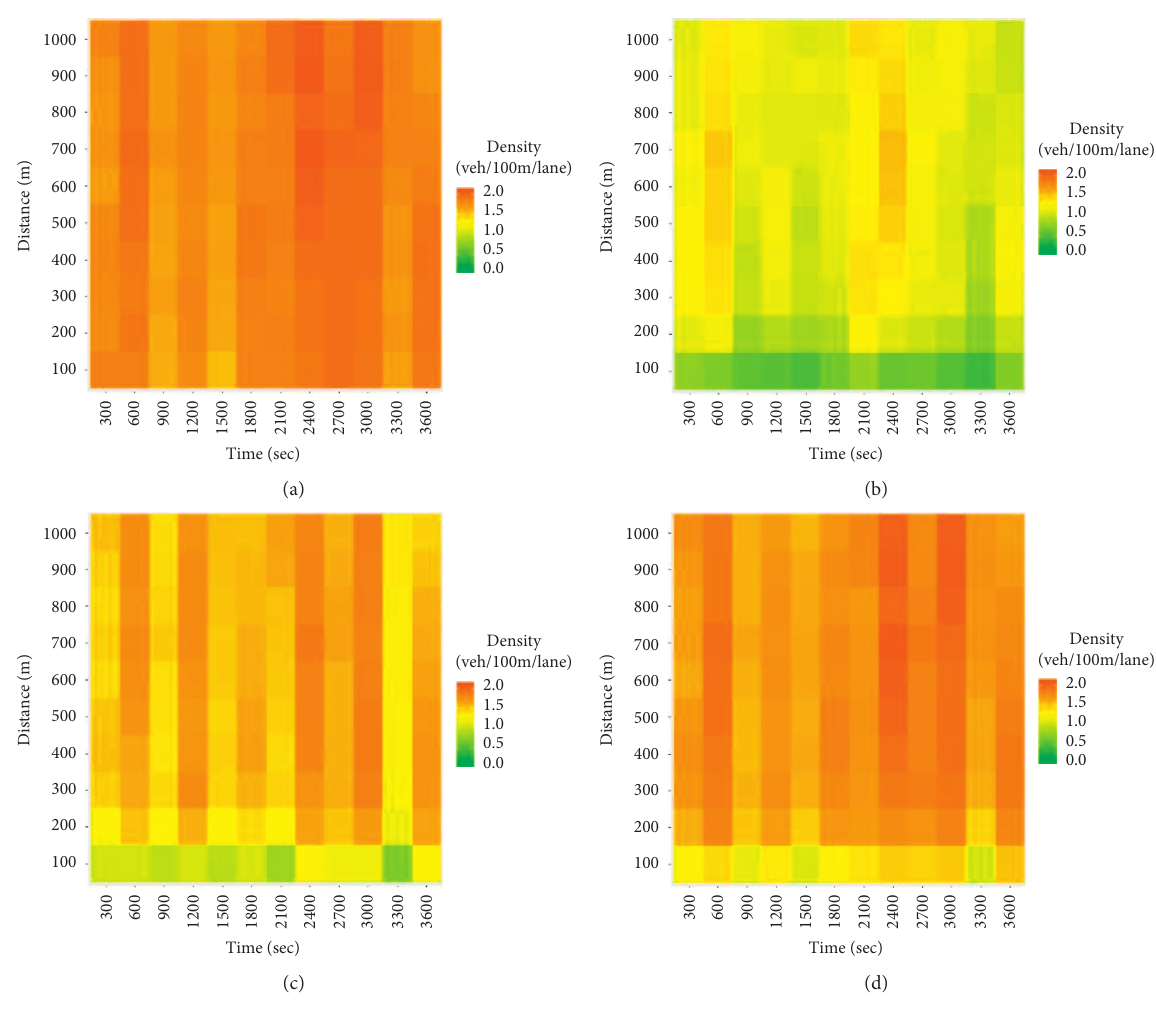
Figure 4: Estimated traffic density by sample rate of scenario 2 (numerical evaluation). (a) Ground truth of traffic density. (b) Estimated density at 10% sample rate. (c) Estimated density at 20% sample rate. (d) Estimated density at 30% sample rate. Table 3: MAPE and RMSE comparison of scenario 2 (numerical